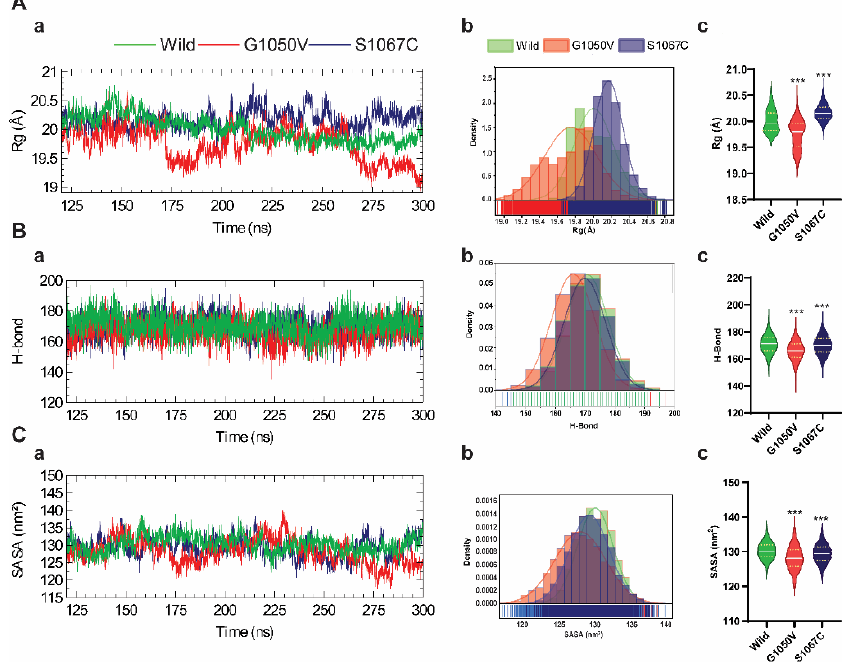
Figure 3. Effect of variants on the protein conformational stability of the NBD1 domain. ( A ) Calculation of radius of gyration (Rg), which is represented as a time-dependent change during the simulation ( a ), probability density ( b ), and the violin plot is highlighting the Rg distribution of each system ( c ). ( B ) Calculation of total intra-residue hydrogen bond represented as a time-dependent change ( a ), probability density ( b ), and the violin plot is highlighting the distribution of total hydrogen bond for the individual system ( c ). ( C ) Calculation of total solvent accessible surface area (SASA), highlighted as a time-dependent change ( a ), probability density ( b ), and the violin plot highlighting the distribution of SASA for each system ( c ). In every case, color in all plots, that is, green, red, dark blue, describes wild, G1050V, and S1067C, respectively. Violin plot highlights the first, median (second), and third quartiles, where the frequency of occurrence corresponds to the width of the box. The annotations used in A-c, B-c, and C-c, represent statistically significant, denoting *** p < 0.0001.